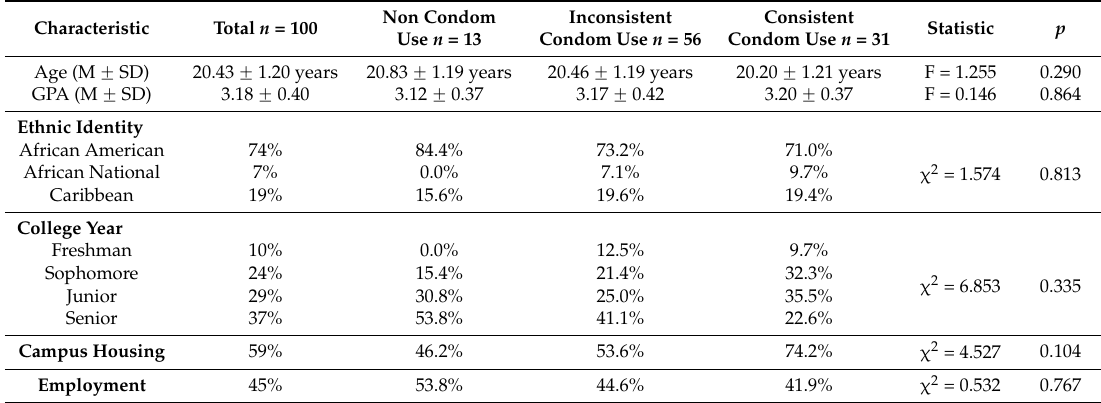
Table 1. Frequency of condom use and demographic characteristics of minority college women.